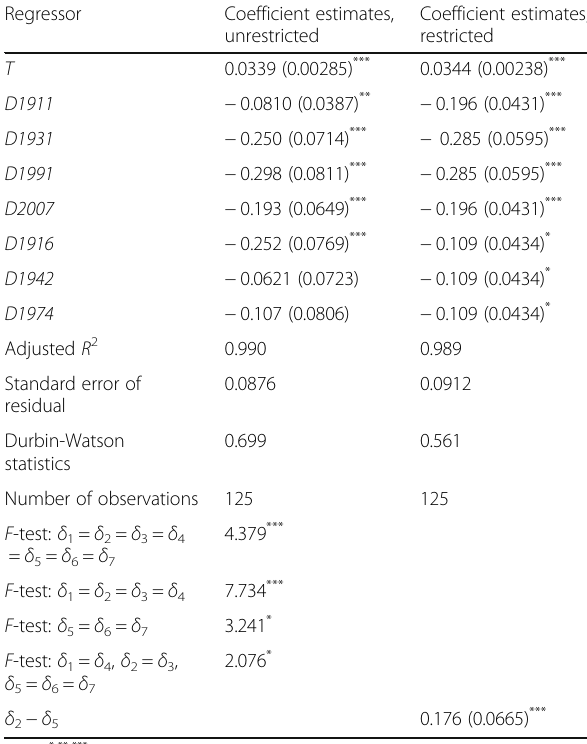
Table 5 Trend model for Swiss GDP and the effects of big crises, 1892 –